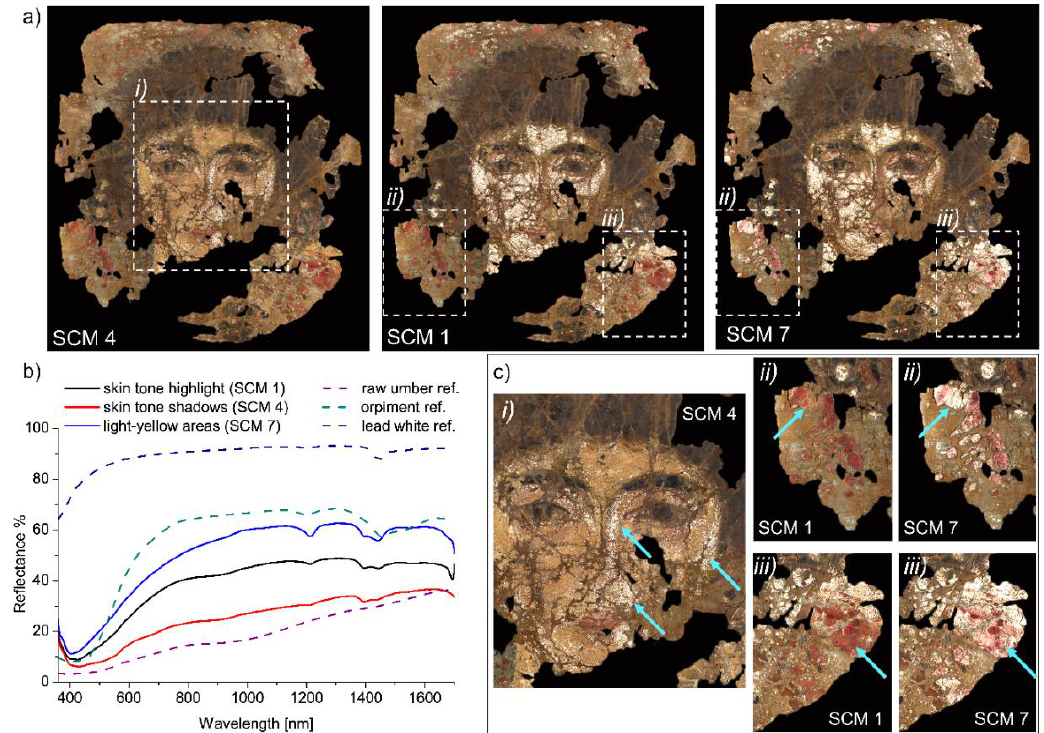
Figure 4. ( a ) SCM 4, 1, and 7 with significant regions ( i , ii , and iii ) highlighted by the white dashed rectangles and magnified in c. Reference spectra and averaged FORS spectra ( b ) of the skin tone (highlight and shadows) and the light-yellow areas acquired in correspondence of the spectral correlation maps. ( c ) Magnified details of SCM 4, 1, and 7. The light blue arrows point out the differences between the three